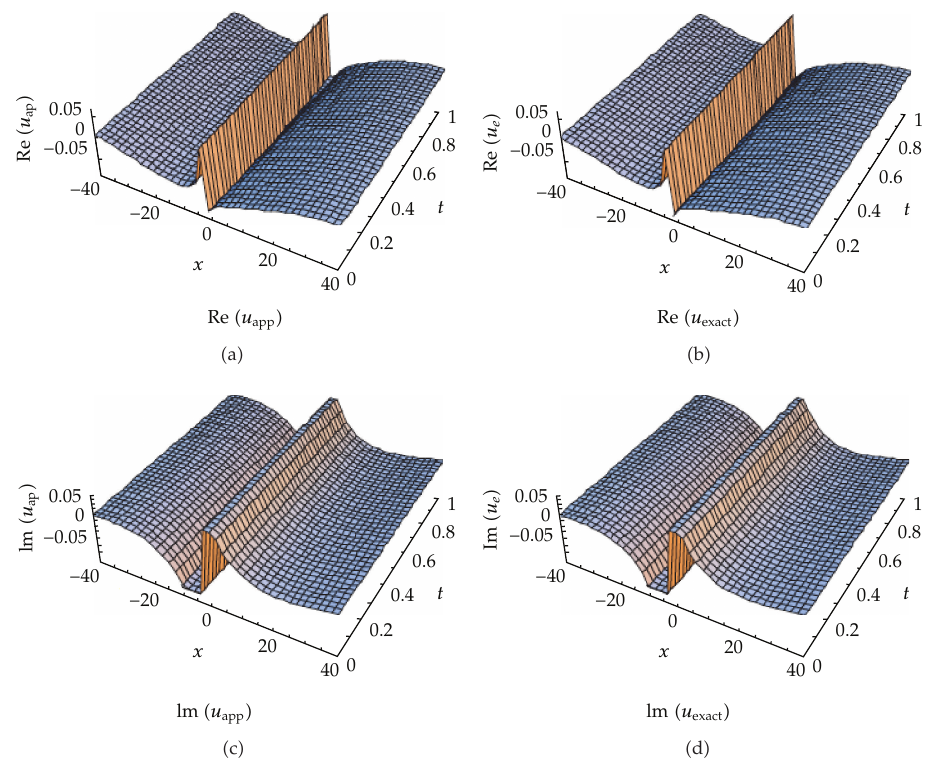
Figure 5: The approximate solution (cid:2) 5.27 (cid:3) in comparison with the exact solution (cid:2) 5.22 (cid:3) if k (cid:7) 0 . 1 ,c (cid:7) 0 . 2 ,ξ 0 (cid:7) 2 , and ξ 1 (cid:7)